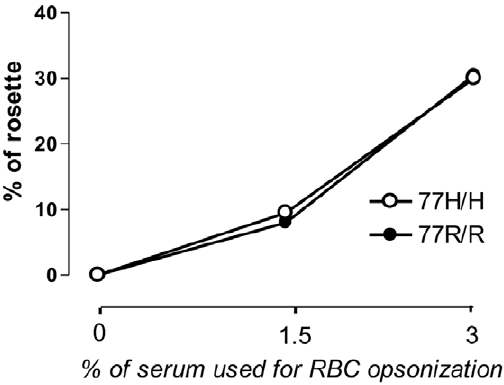
Figure 3. Rosetting assay. Percentage of rosettes formed by CFSE- labelled RBC-hiC3b with freshly isolated PMNs from donors carrying the susceptible allele (77H/H, open symbol) or the common allele (77R/R, closed symbol). One representative assay out of 3 independent experiments.